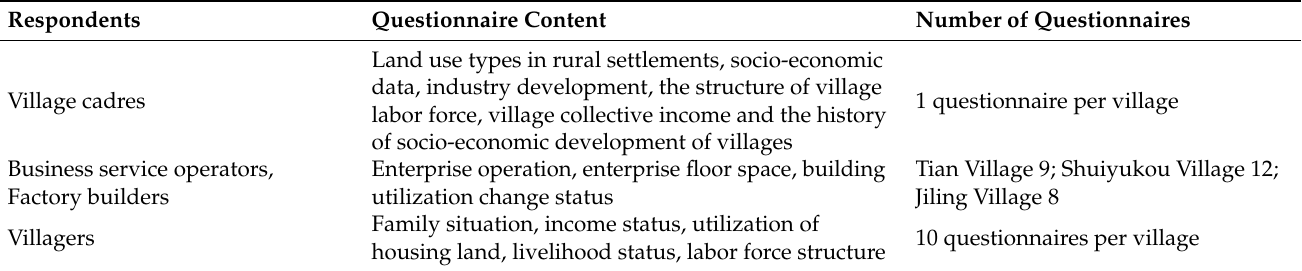
Table 1. Content of the